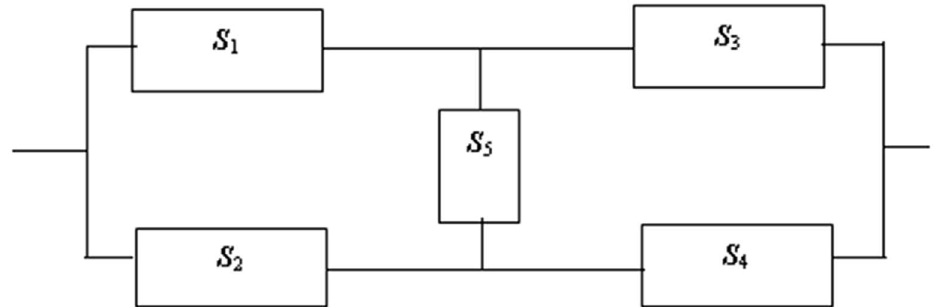
Fig 1. The branching program of a bridge-type complex